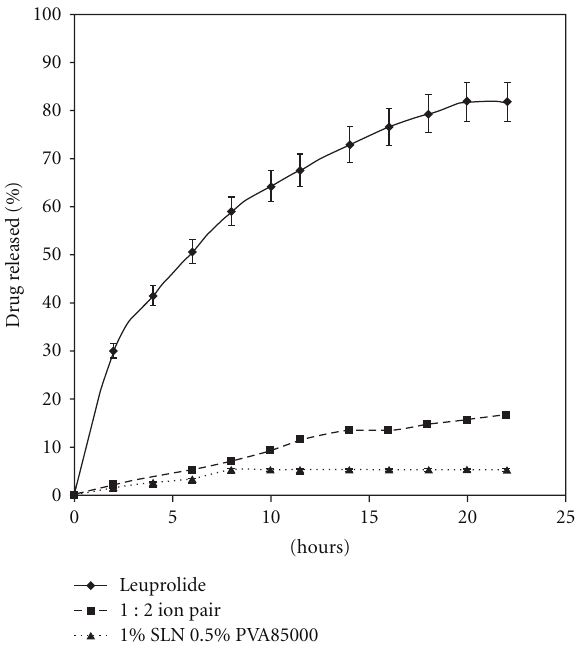
Figure 2: leuprolide release from SLN: method of di ff usion through hydrophilic